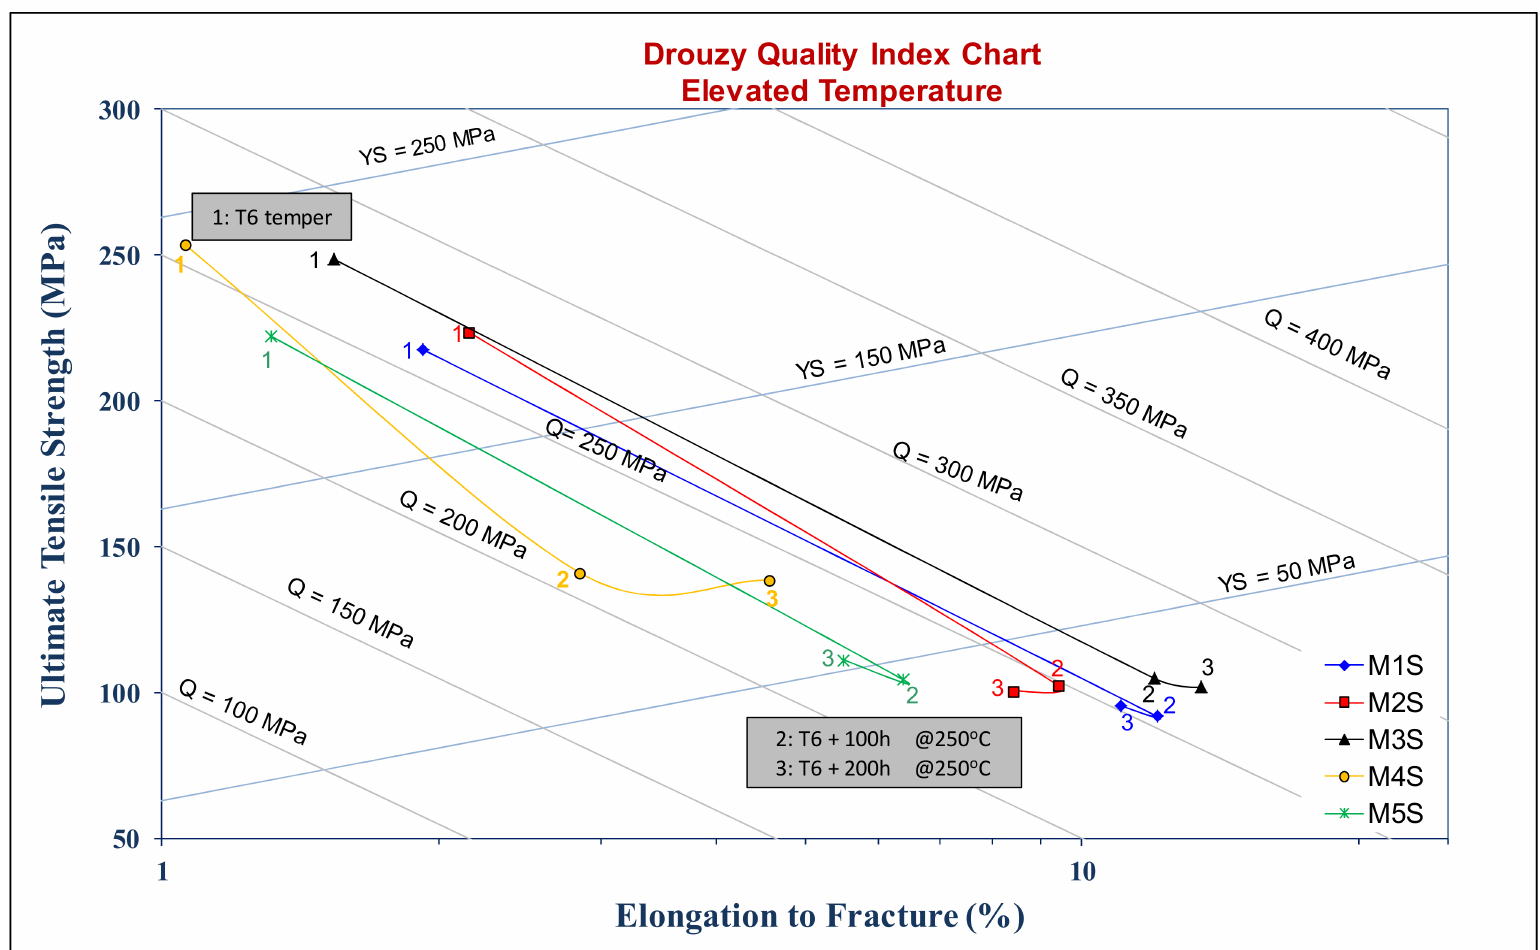
Figure A4. Drouzy quality chart representing the relation between the UTS and the percent elongation to fracture of alloys M1S through M5S in the T6-treated condition, before and after stabilization at 250 ◦ C for 100 and 200 h (testing at 250 ◦